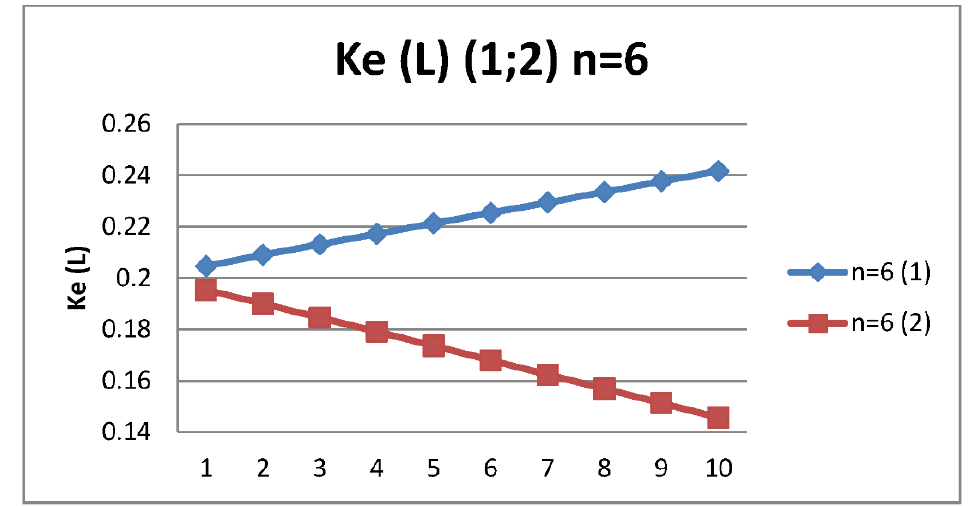
Figure 6. Dependence of the equity cost, k e , on leverage level L in the cases of payments of tax on profit at the end of the year (1) and in the beginning of the year (2) for six-year company.